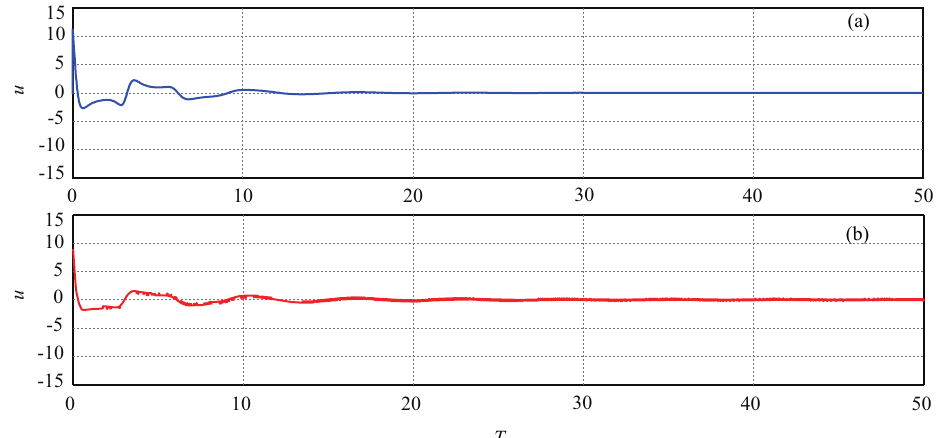
Figure 4. Curves of the dimensionless ball rotational angle with a continuous disturbance [( a ) Pro- posed method; ( b ) Method in [35]].